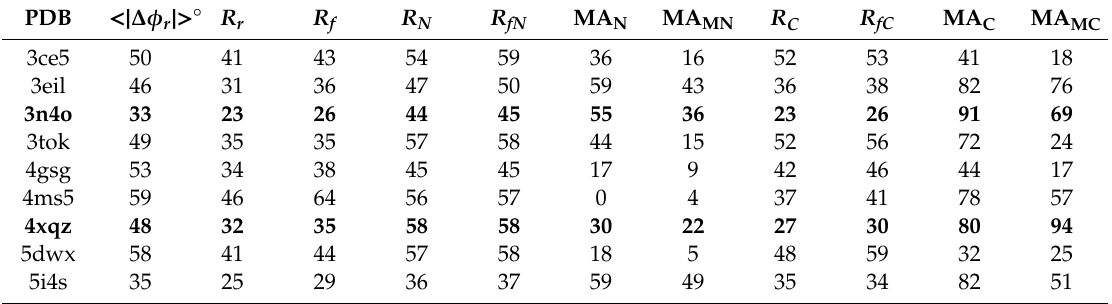
Table 2. NAUTILUS and cyclic automated model building (CAB) results. For the 29 test structures, PDB is their PDB code, <| ∆ φ r |> ◦ is the average phase error at the end of SYNERGY, R r and R f are the crystallographic residuals (for all of the data) and the Rfree value. The corresponding φ r phases are the input for NAUTILUS and CAB. R N , R fN , MA N and MA MN are the R , R f , MA and MA M values obtained after the application of NAUTILUS; R C , R fC , MA C and MA MC are the corresponding values obtained at the end of CAB. R and MA values are